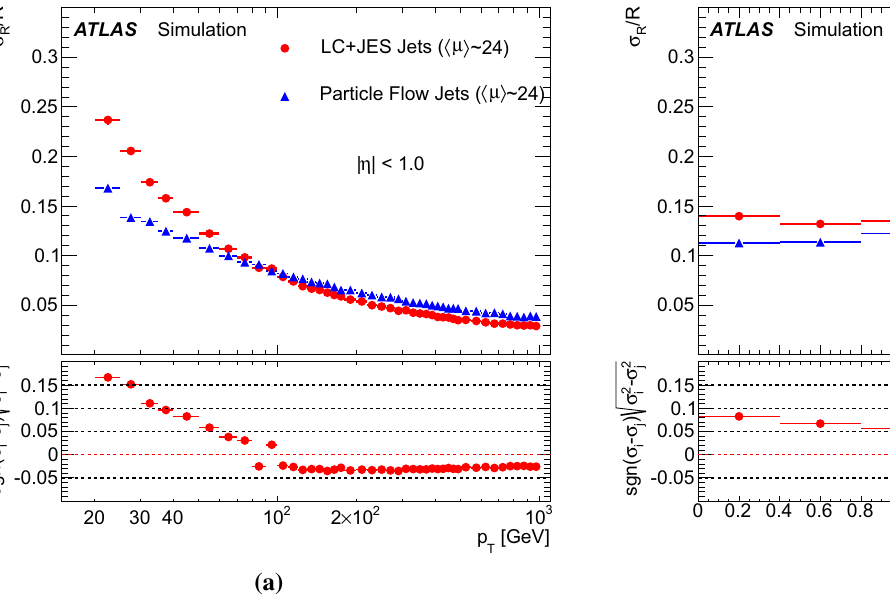
Fig. 26 Thejettransversemomentumresolutionasdeterminedindijet MCeventsforcalorimeterjetsandparticleflowjets.Subfigure( a )shows the resolution as a function of p T for jets with | η | < 1 . 0 and ( b ) shows the resolution as a function of | η | for jets with 40 < p T < 60GeV.